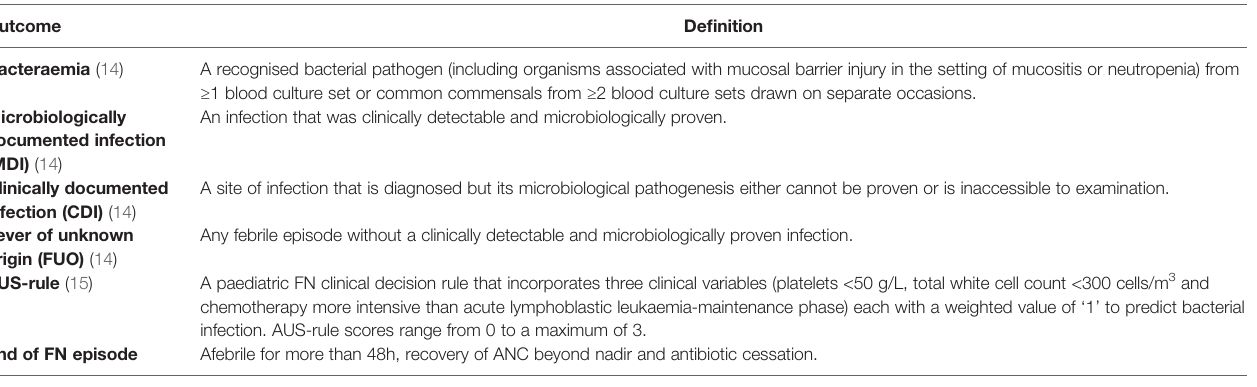
TABLE 1 | De fi nitions of outcomes included in